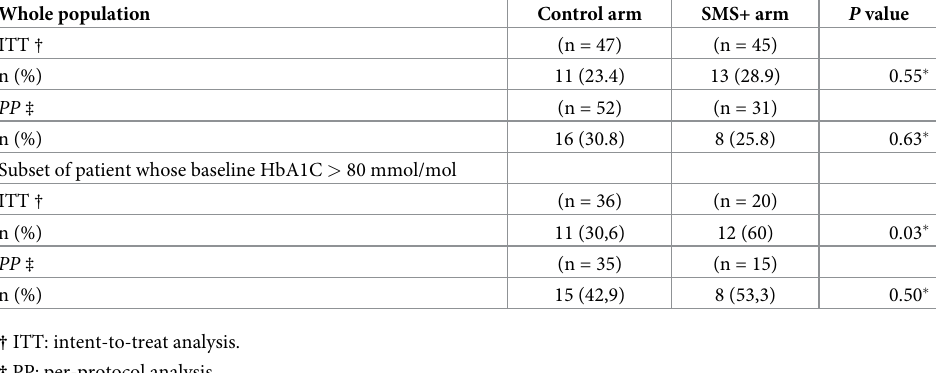
Table 3. Number of patients whose HbA1c level decreased by at least 1% between baseline and 6